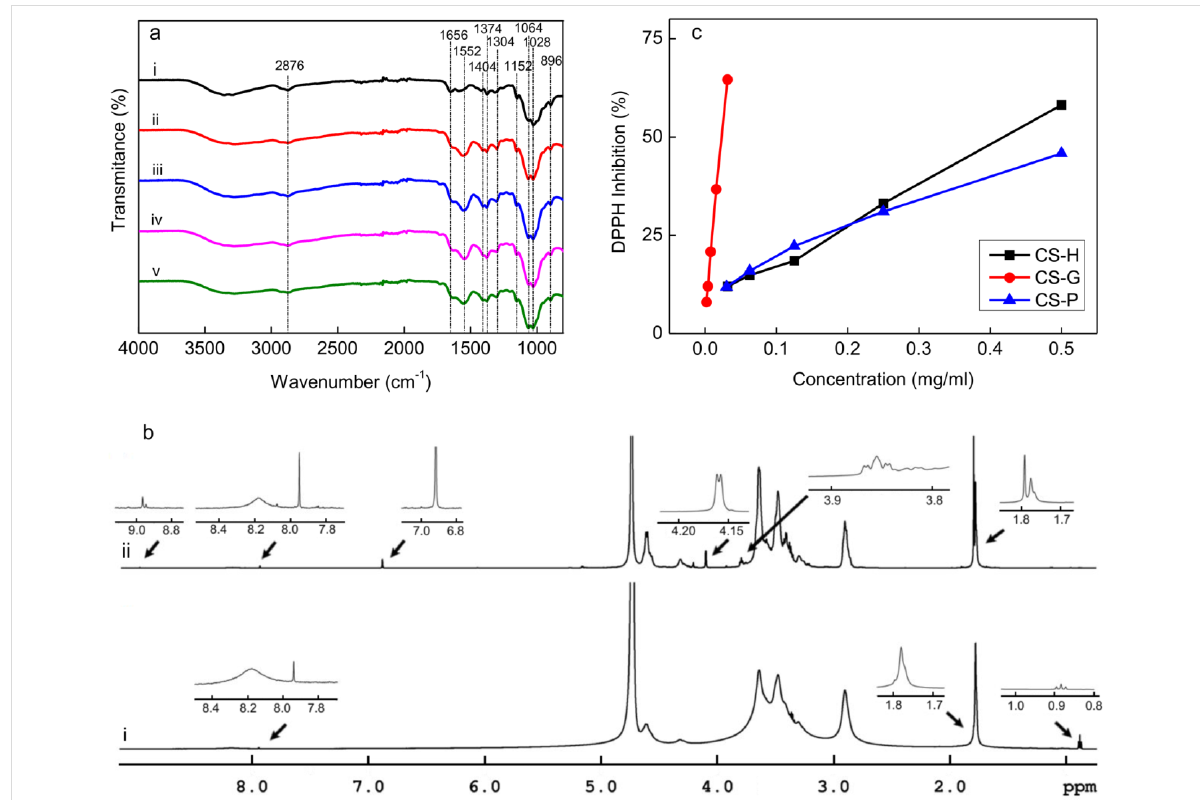
Figure 1: ATR-FTIR spectra of (a) chitosans: (i) precursor chitosan before modification, (ii) chitosan after degradation by the H 2 O 2 /ascorbic acid redox system and modification with (iii) gallic acid (CS-G), (iv) hydroquinone (CS-H), and (v) phloroglucinol (CS-P). (b) 1 H NMR spectra of (i) CS and (ii) CS-G. (c) Dependence of DPPH inhibition on the concentration of modified chitosans.